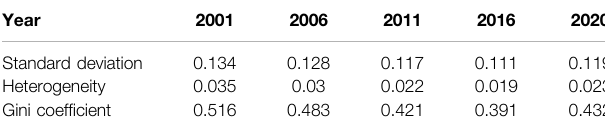
TABLE 3 | Statistics in coreness of water network in the